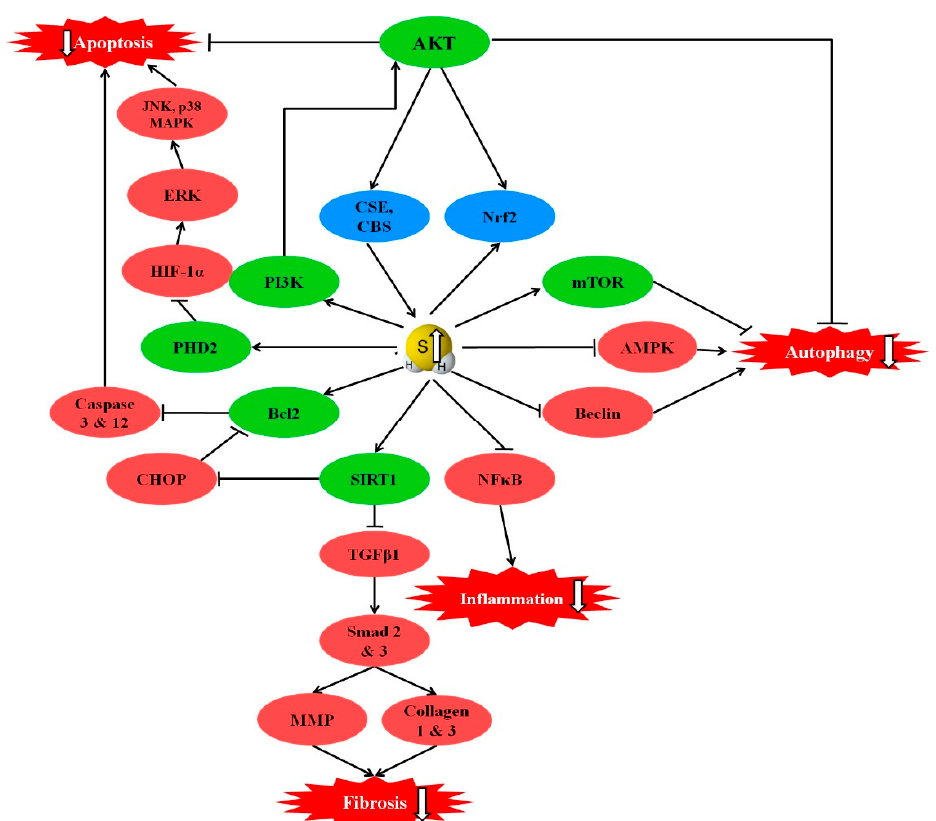
Figure 3. The signaling pathways underlying H 2 S regulation of inflammation, apoptosis, fibrosis, and autophagy. Abbreviations: Bcl2, B-cell lymphoma 2; CHOP, C/EBP homologous protein; CBS, cystathionine β -synthase; CSE, cystathionine γ -lyase; ERK, extracellular signal-regulated kinase; HIF-1 α , hypoxia-inducible factor 1-alpha; JNK, c-Jun N-terminal kinase; MAPK, mitogen-activated protein kinase; MMP, matrix metallopeptidase; mTOR, mammalian target of rapamycin; TGF β 1, transforming growth factor beta